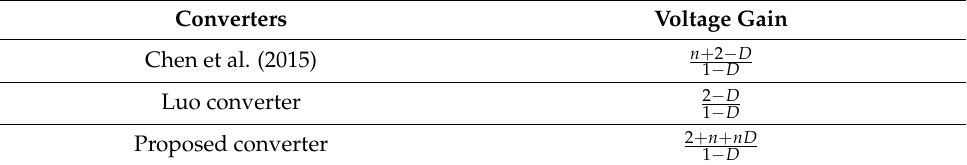
Table 2. Comparisons with other relevant